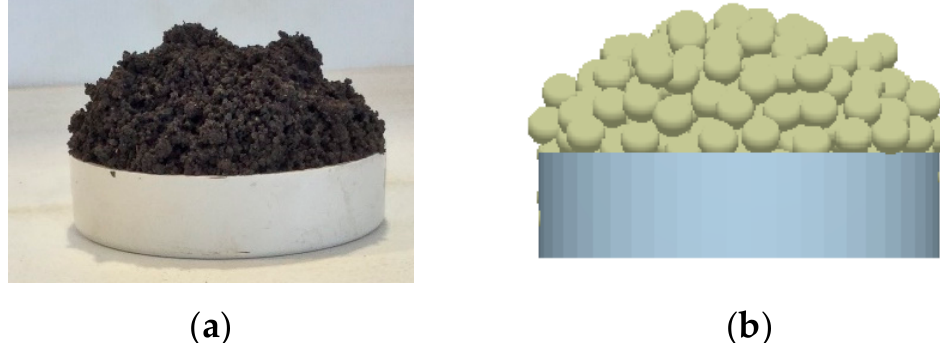
Figure 9. Repeatable dome-like soil pile obtained in the angle of repose test for a loose cohesive soil by Aikins et al. [41]: ( a ) laboratory experiment and ( b ) optimized DEM simulation.